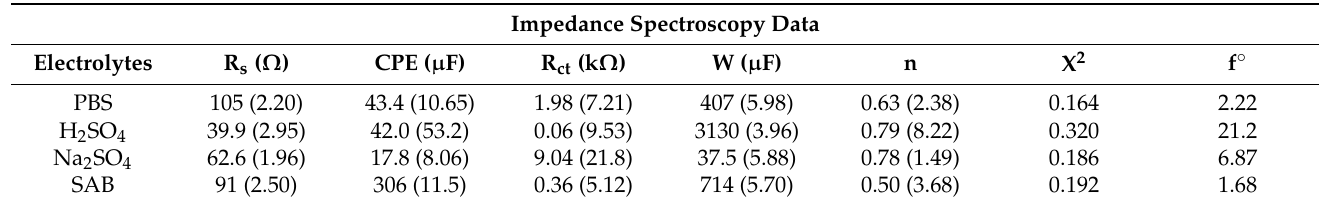
Table 3. Comparative summary of EIS results of GCE-NiPcMWCNTs-modified electrodes in all the electrolytes. Impedance Spectroscopy Data